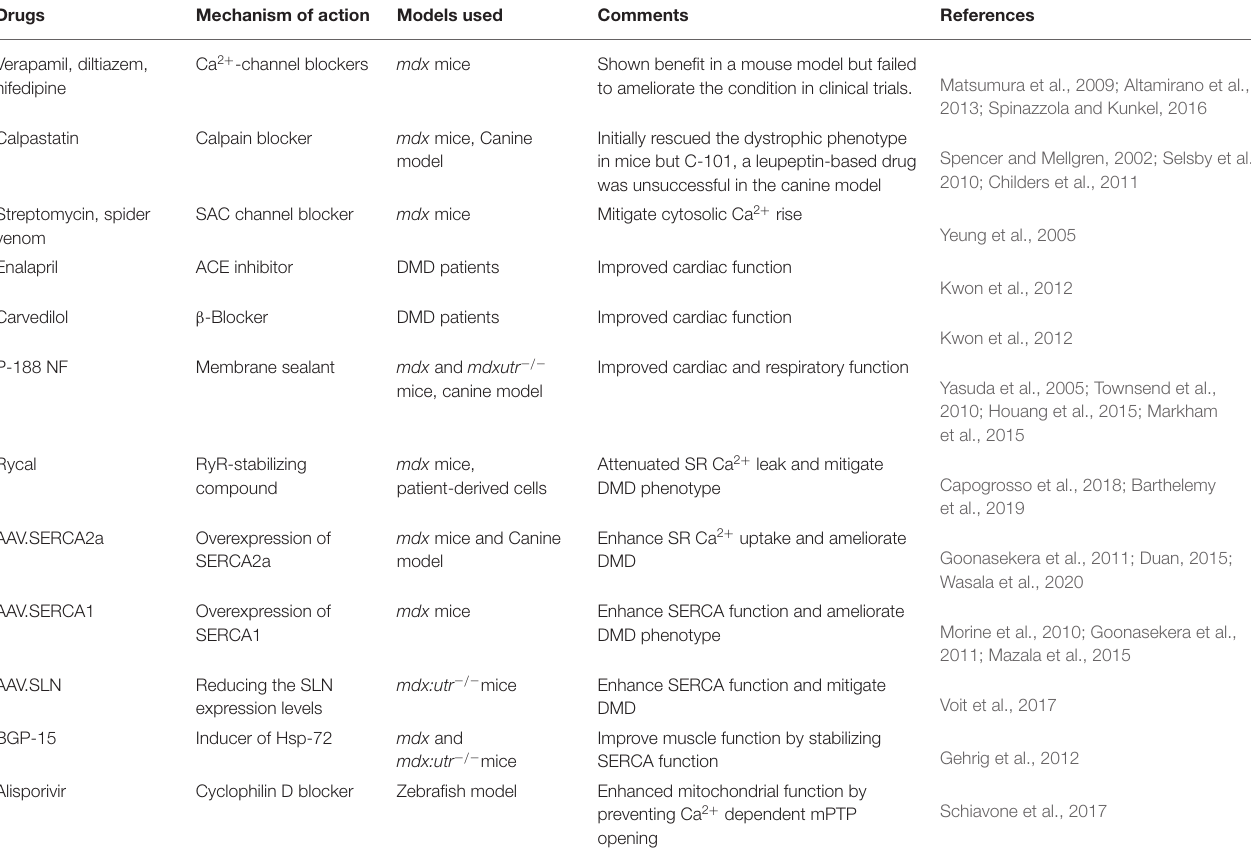
TABLE 1 | Therapies targeting dysregulated Ca 2 + directly or